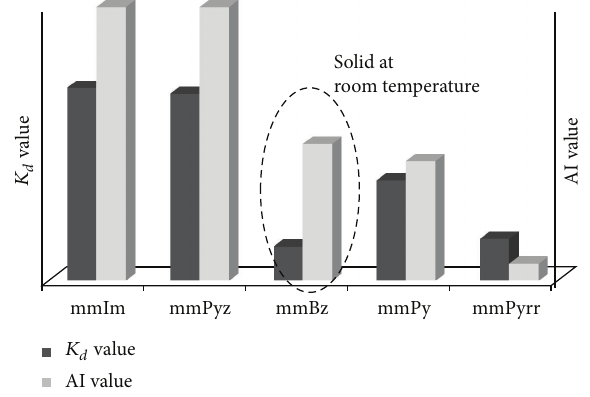
Figure 5: Comparison of AI value and desulphurization partition coefficient ( 𝐾 𝑑 value) of cations solely with MSO 4 .